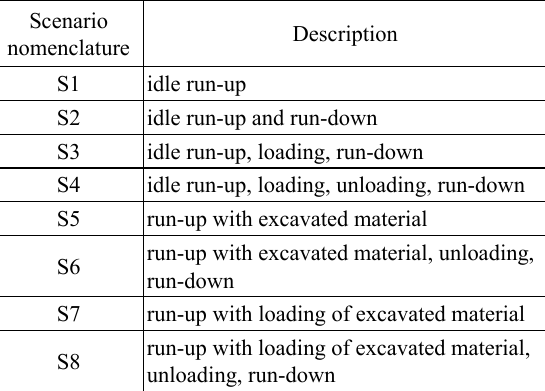
Table 4. Possible scenarios in the simulator